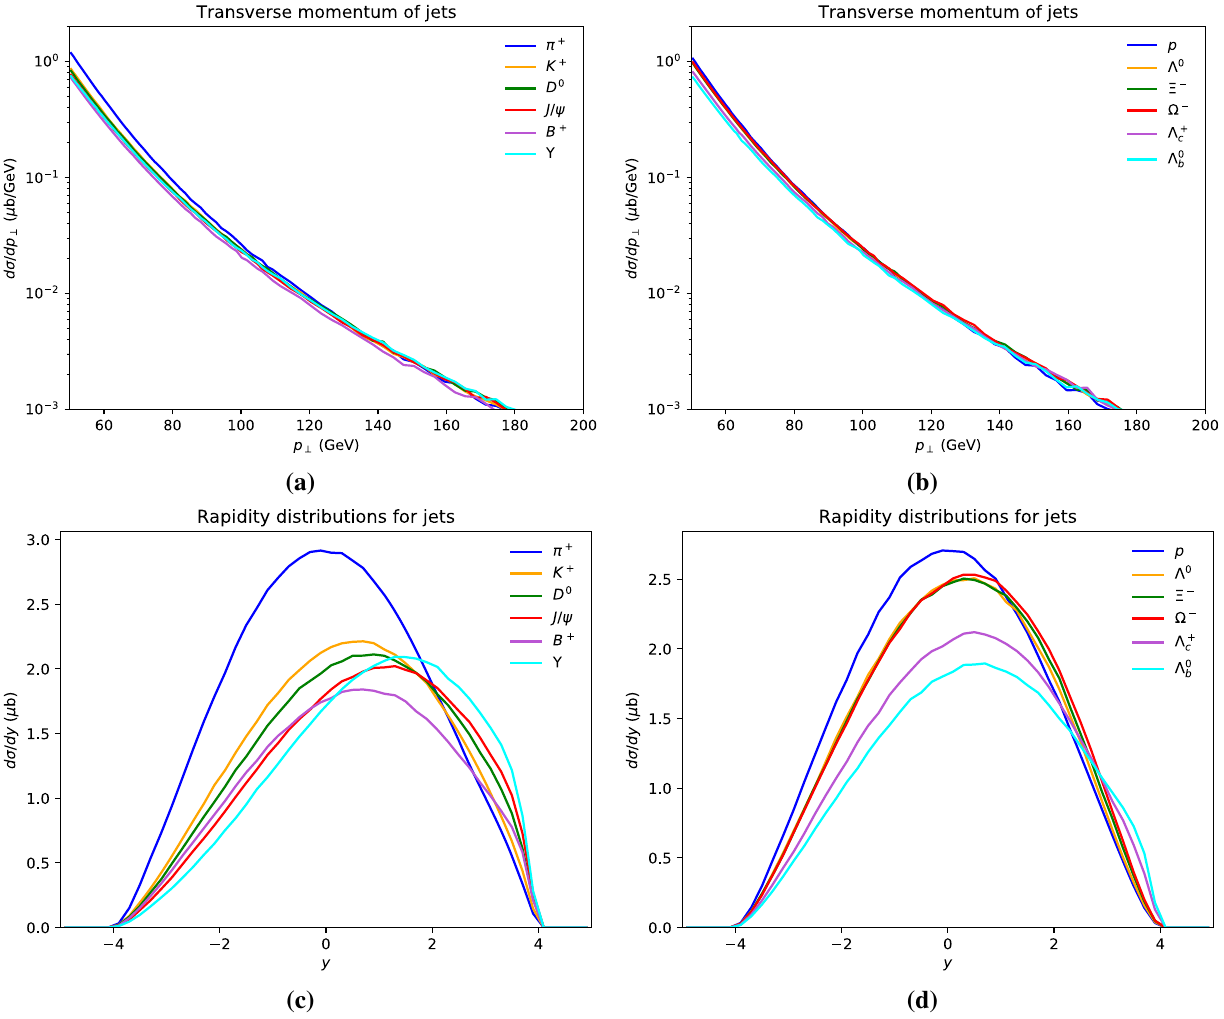
Fig. 8 a , b Jet p ⊥ and c , d rapidity differential cross sections (in units of μ b), with p ⊥ , min = 50 GeV. Average values are shown in Table 4. Labels denote the respective hadron beam